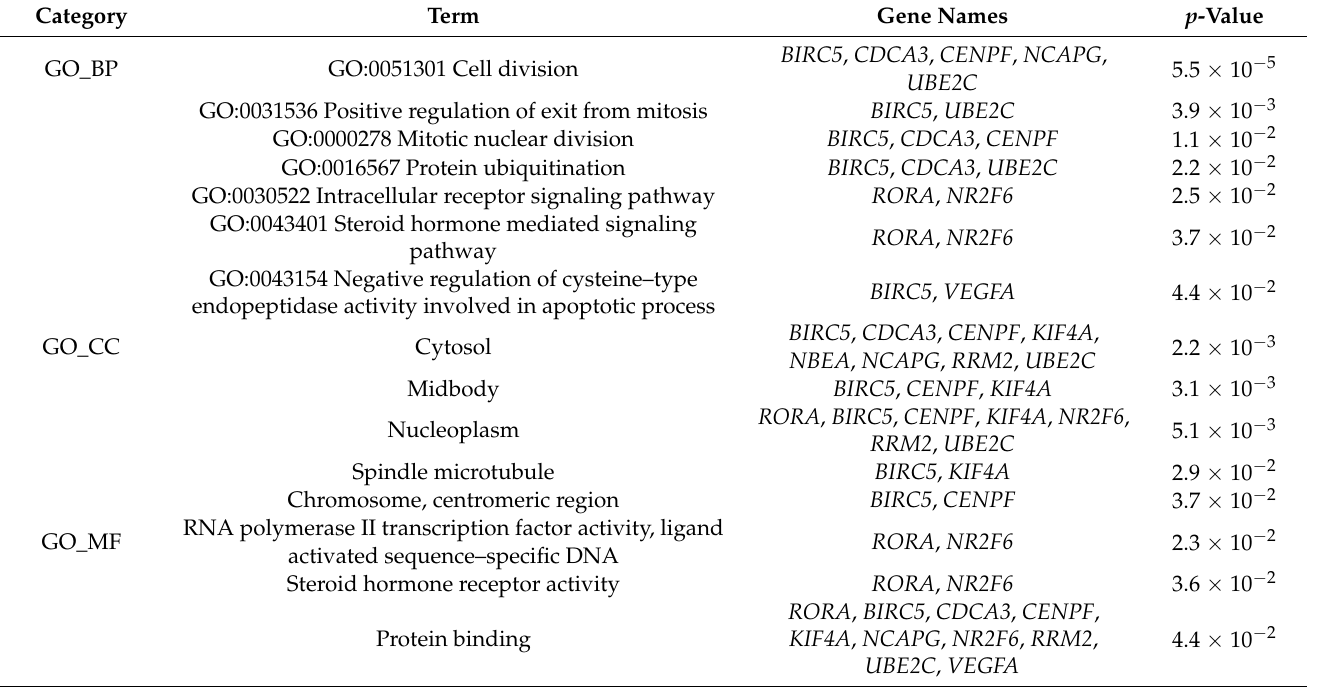
Table 6. GO terms of DEGs in serous ovarian